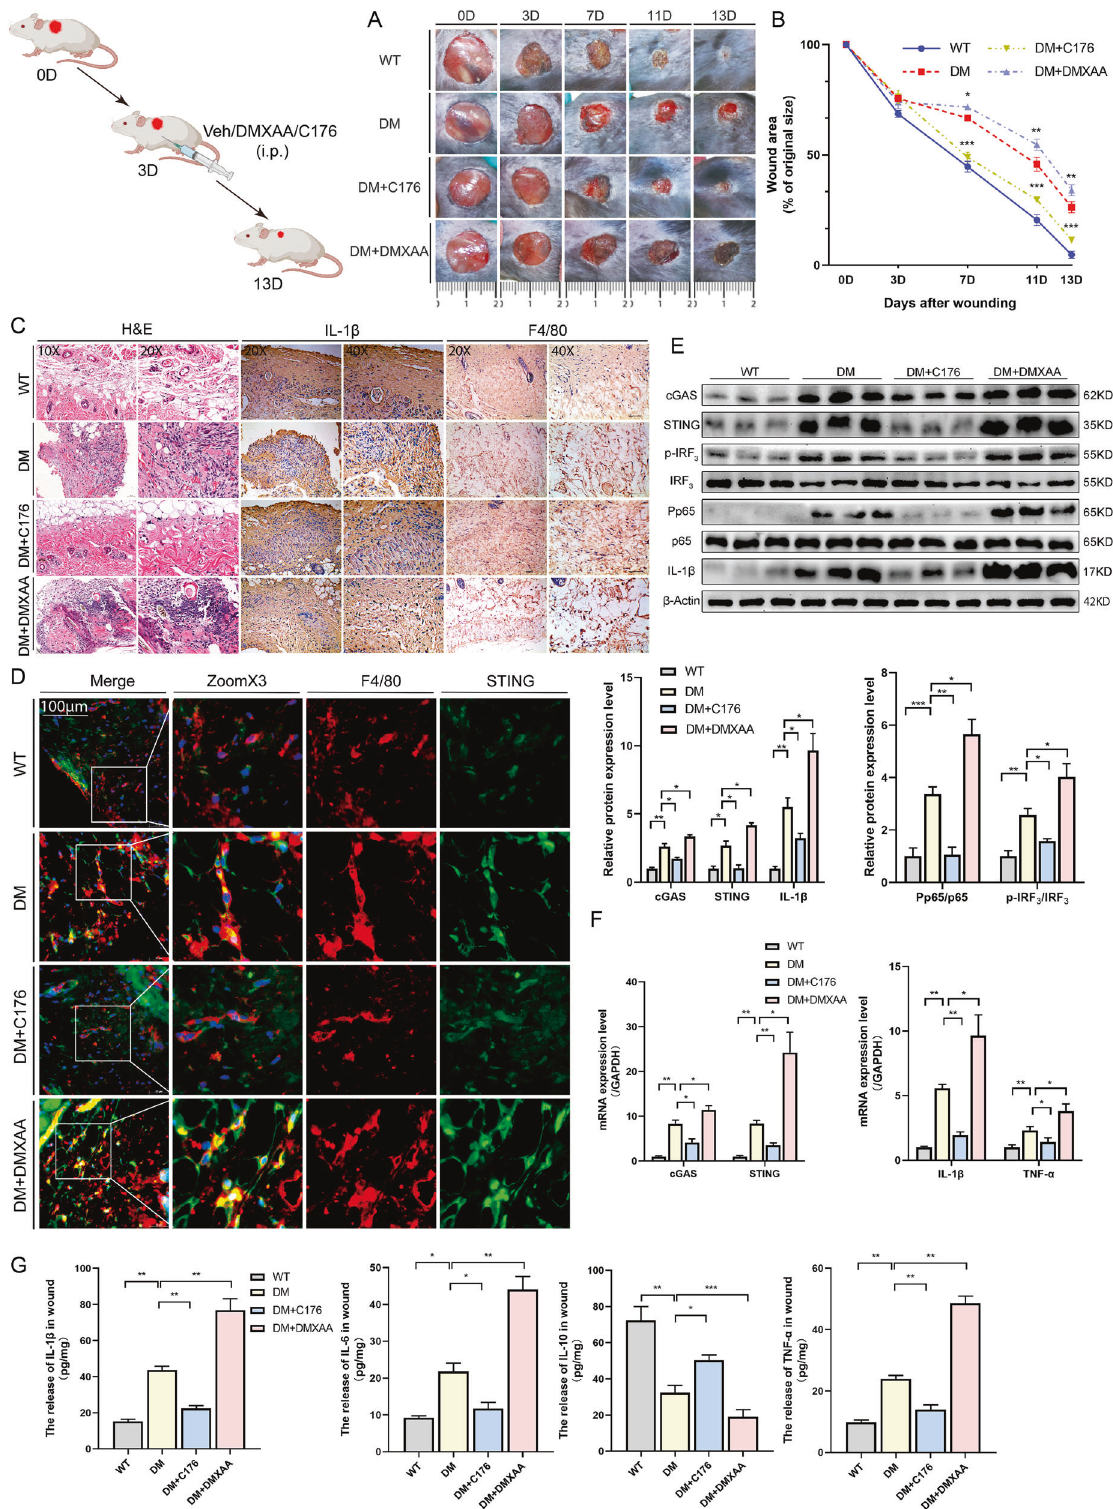
STING − / − -CM reversaled this phenomenon (Fig. 6E). VEGF and CD31 are important growth factors affecting angiogenesis. We then observed the effects of WT and STING − / − BMDM super- natants under NC and HG conditions on VEGF and CD31 secretion in MEVs by Living cell imaging microscopy. The results showed